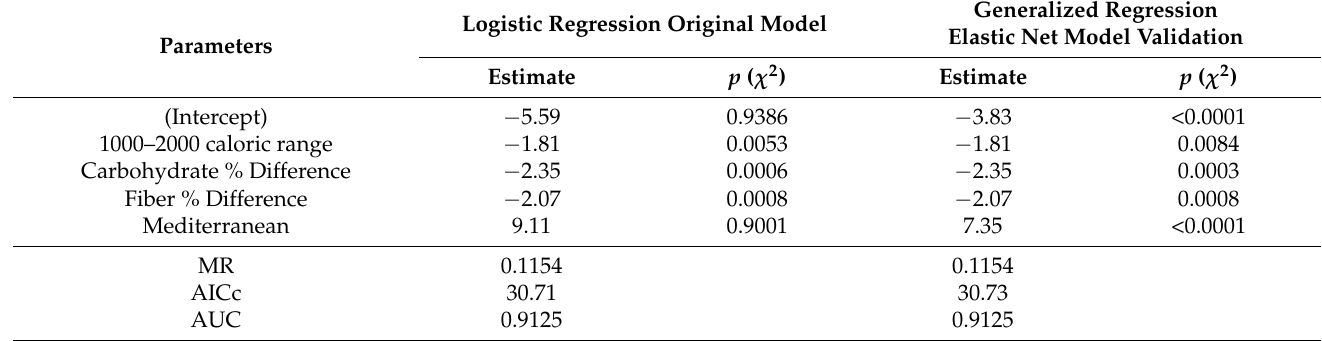
Table 4. Significant factors contributing to the differences between mobile application a nd Food Frequency Questionnaire on folate.